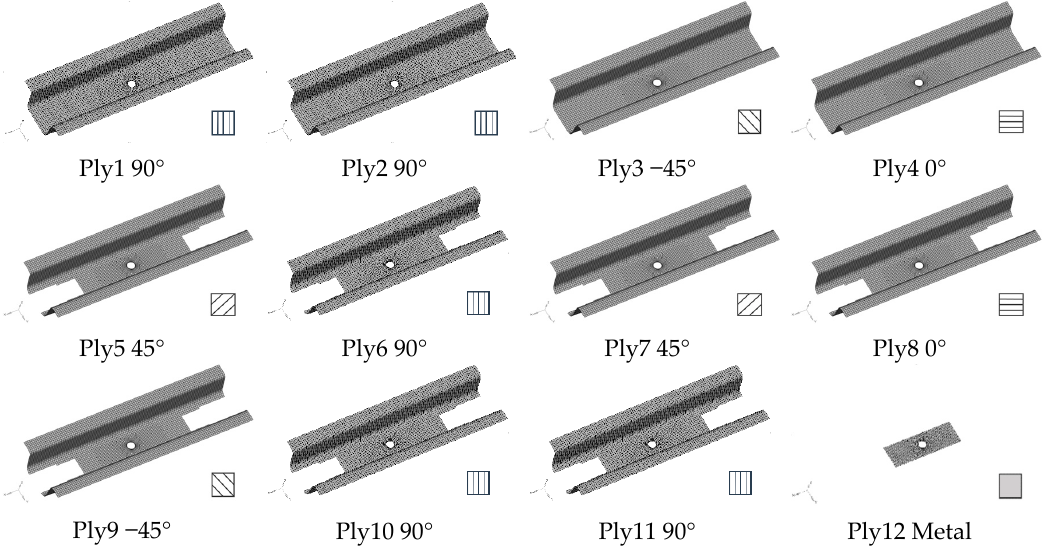
Figure 5. Smoothed layout of each layer after postprocessing.